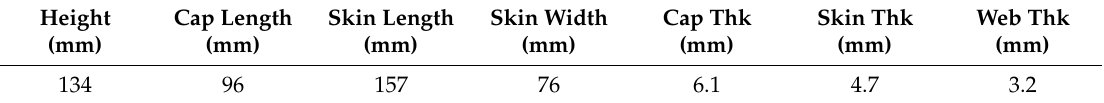
Table 1. Dimensions of T-Pull